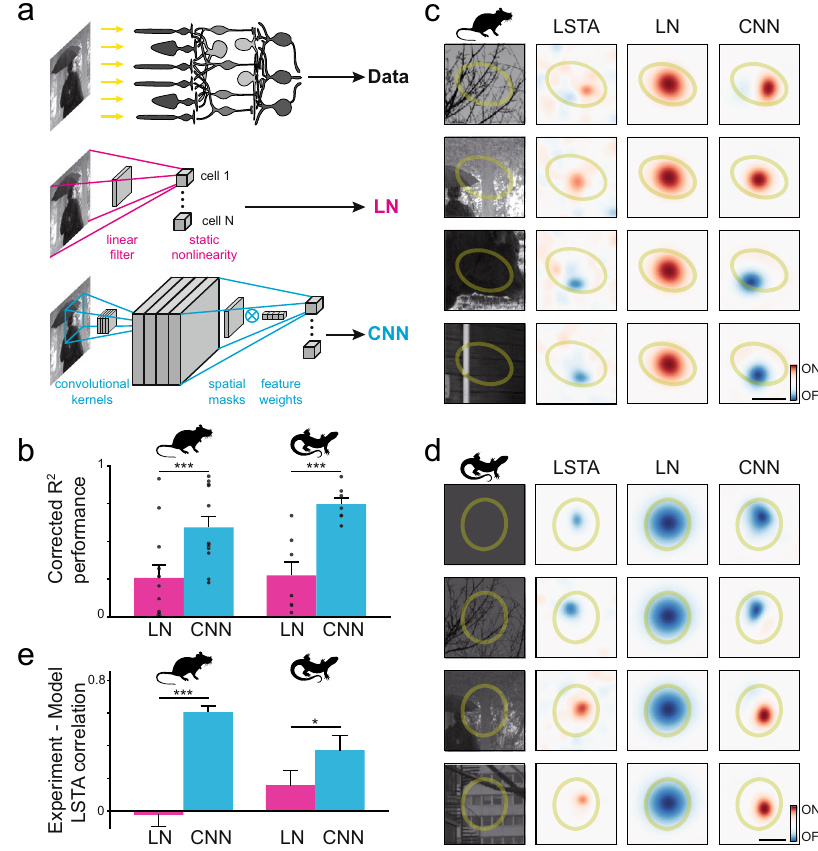
Fig.2|Anon-linear,convolutionalNeuralNetworkmodelpredictstheshapeof theLSTAs.a Schematicofthedifferentarchitecturesusedtopredicttheresponses ofmultipleretinalganglioncellstoa fl ashedimage(top).TheLNmodel(middle)is composed by a linear fi lter followed by a nonlinear function. The CNN model (bottom) is composed of a convolutional layer (inferredkernels) and a dense layer (readout weights factorized in spatial masks and feature weights). b Average per- formance of the two models at predicting the average responses to repeated, unperturbed natural images (see Methods and Supplementary Fig. 4 for a scatter plot of this data across all modelled cells). The data reported here is from N =12 (mouse) and N =7 (axolotl) cells that were both modelled and showed polarity inversion.InbothspeciestheCNNsigni fi cantlyoutperformstheLN( p =1x10 (cid:1) 3 for